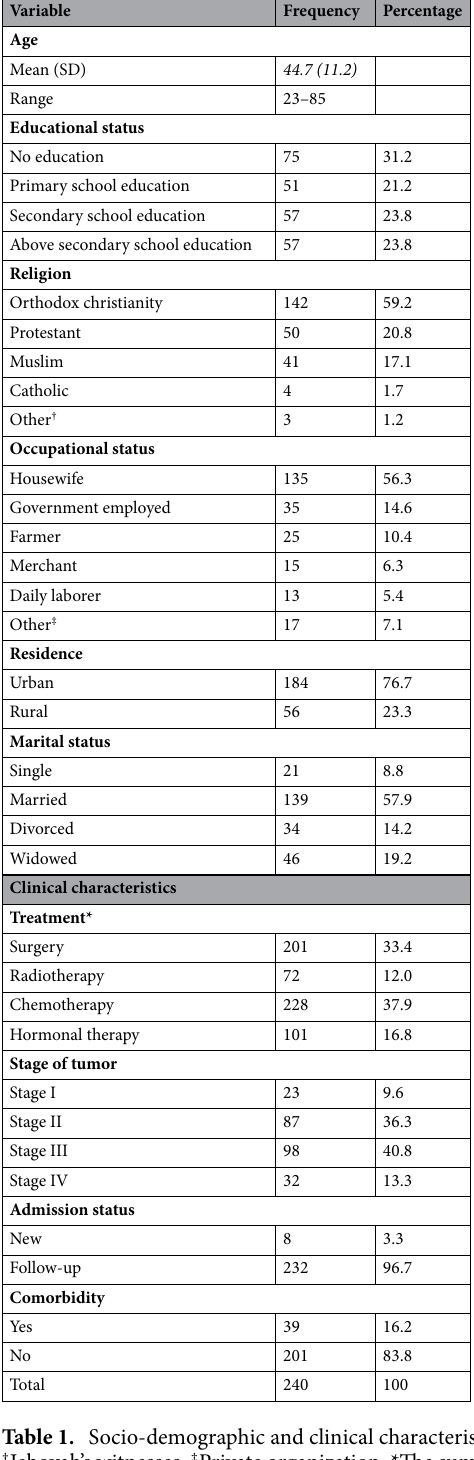
Table 1. Socio-demographic and clinical characteristics of breast cancer patients in Ethiopia, 2021 (N = 240). † Jehovah’s witnesses. ‡ Private organization. *The sum of frequency is greater than total because it is multiple response